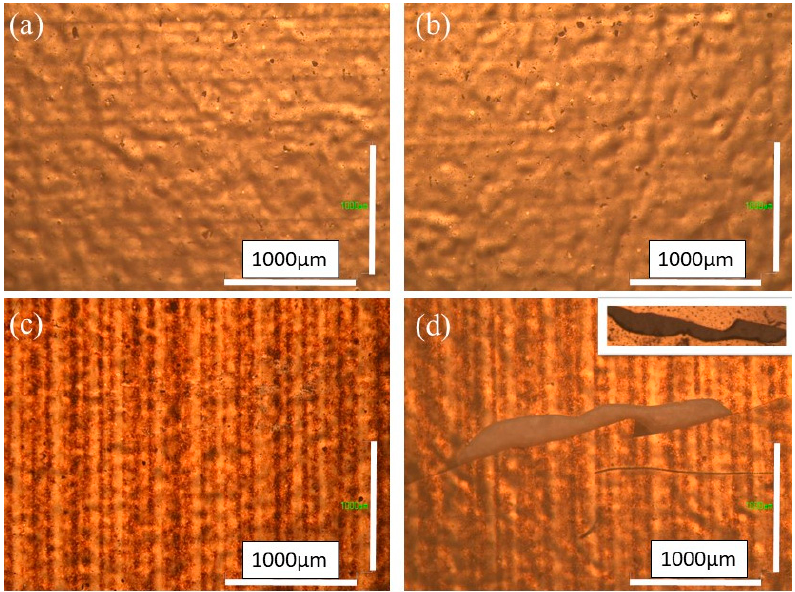
Figure 7. Optical microscopy images of the PEDOT:PSS ink pattern after one pass ( a ) before and ( b ) after removal of adhesion tape, and after five passes ( c ) before and ( d ) after removal of the adhesive tape.